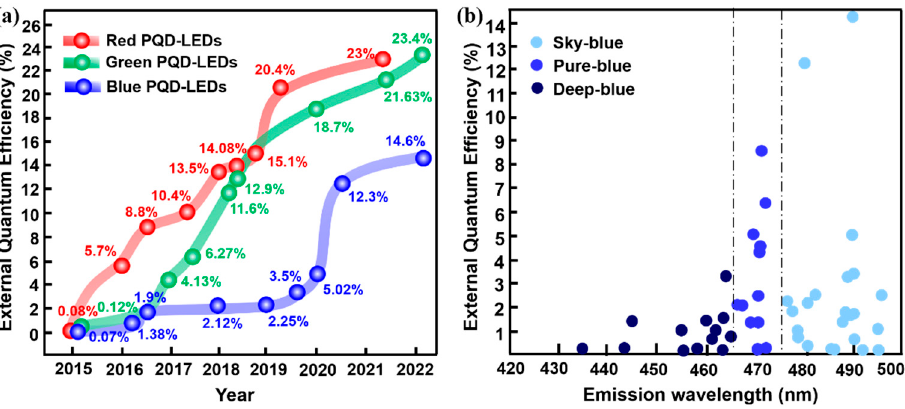
Figure 1. ( a ) Progress diagram of the EQEs for the reported PeQLEDs; ( b ) EQEs of the reported sky– , pure–, and deep–blue